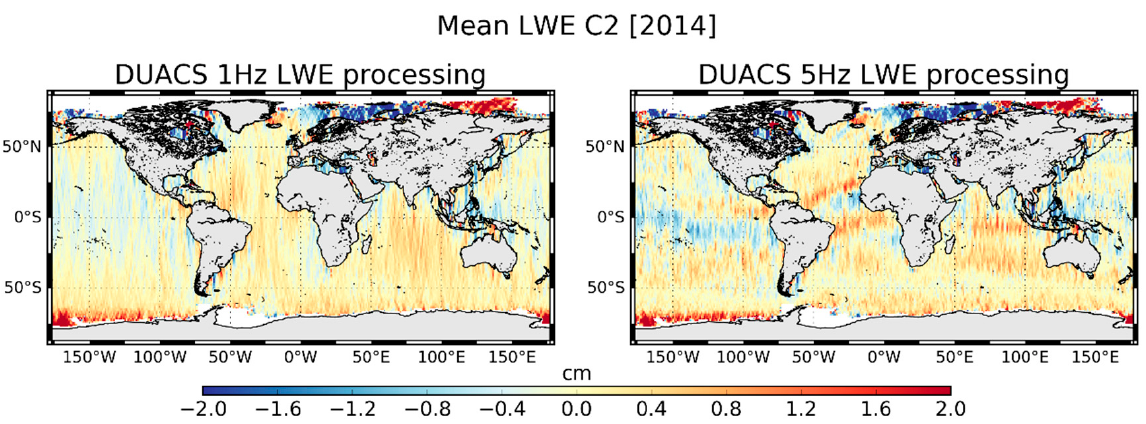
Figure 3. Mean LWE correction for C2 data in 2014. LWE correction obtained when applying the DUACS 1Hz processor (left) and 5Hz processor (right).